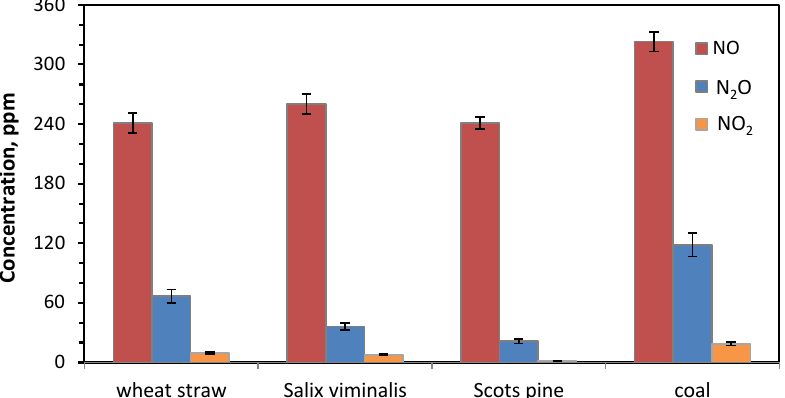
Figure 10. Total emissions of NO, N 2 O and NO 2 during combustion in oxy-21 atmosphere. Vertical bars represent standard deviation.